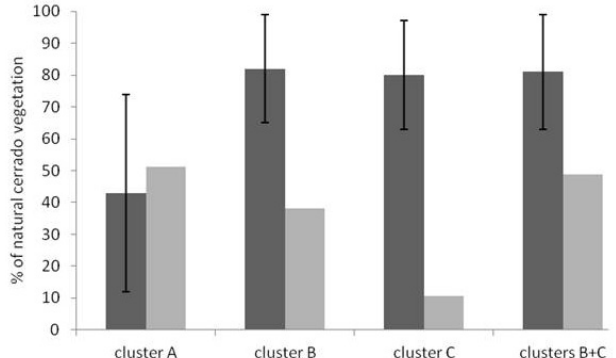
Fig 3. Percentage and standard deviation of natural cerrado vegetation in cluster A, B, C and B+C (dark gray) and percentage of occurrence of non-random clustered common species (light